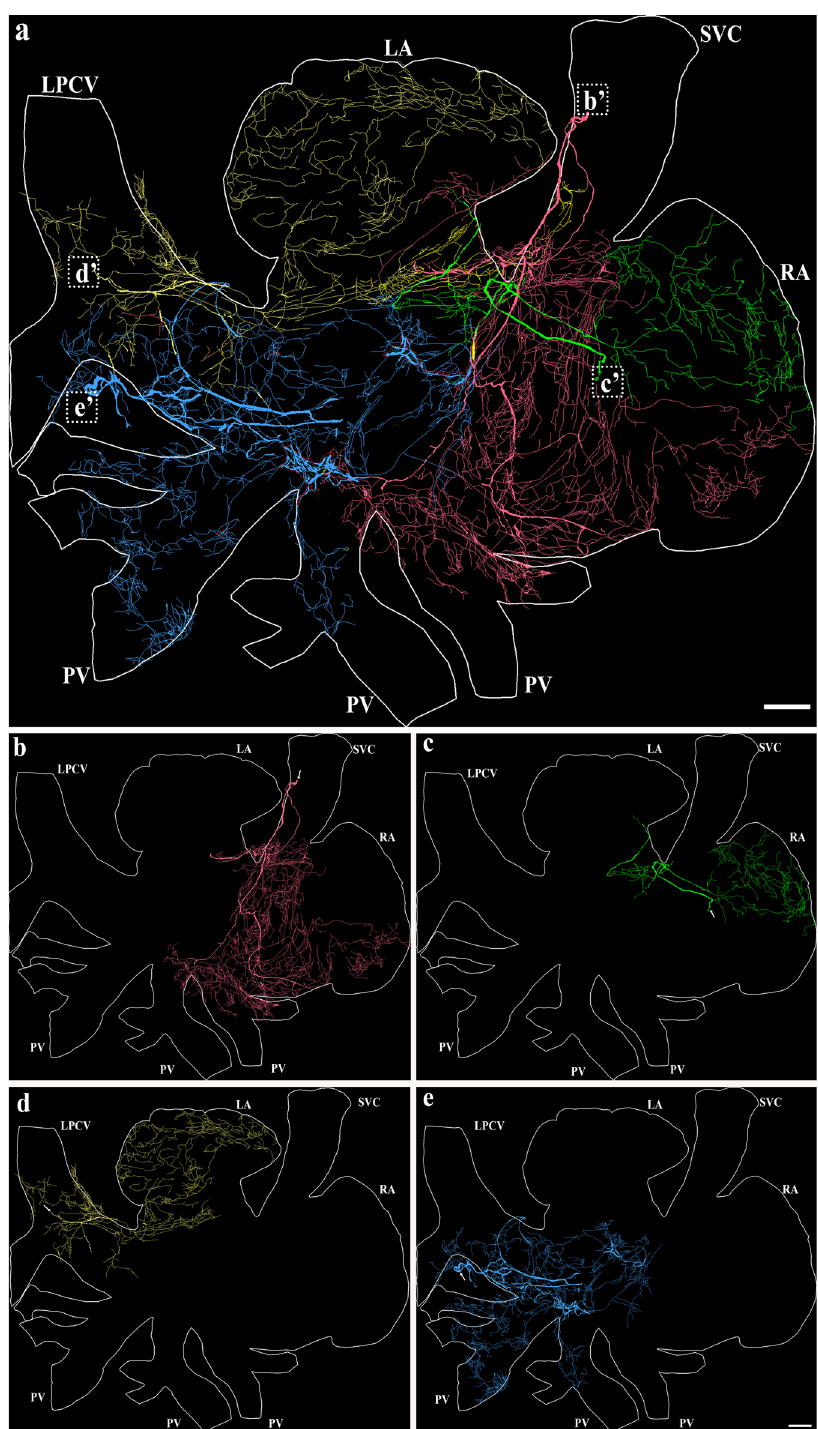
Figure 4. Neurolucida 360 tracing and digitizing of the TH-IR bundles and axons innervating the RA and LA (connected). ( a ) Tracing of TH-IR bundles revealed ~ 4 major bundles entered the atria mainly at the SVC, LPCV or LA-PV junction then bifurcated into small bundles that eventually ramified into individual varicose axons. Two bundles extended the TH-IR axons towards the RA while the other two bundles mainly innervated the LA. These four bundles innervated distinct regions with a certain degree of overlap. ( b ) TH-IR bundle that extended projections mainly towards the base of SVC, SAN, AVN, the lower part of the RAu. ( c ) A TH-IR bundle that extended projections towards the upper part of the RAu, SAN, LA and RA junction, and the medial part of the LA. ( d ) A TH-IR bundle that accessed the LA through the LPCV and mainly innervated the LPCV, the LAu, and the middle of the LA. ( e ) TH-IR bundles entered the LA between LPCV and the left PV to mainly innervate the LPCV, the left and middle PVs, the middle part of the LA and the junction of LA and RA. Arrows indicate the beginning of the parent axon bundle. RA right atrium, LA left atrium, LPCV left precaval vein, SVC superior vena cava. Scale bar: 500